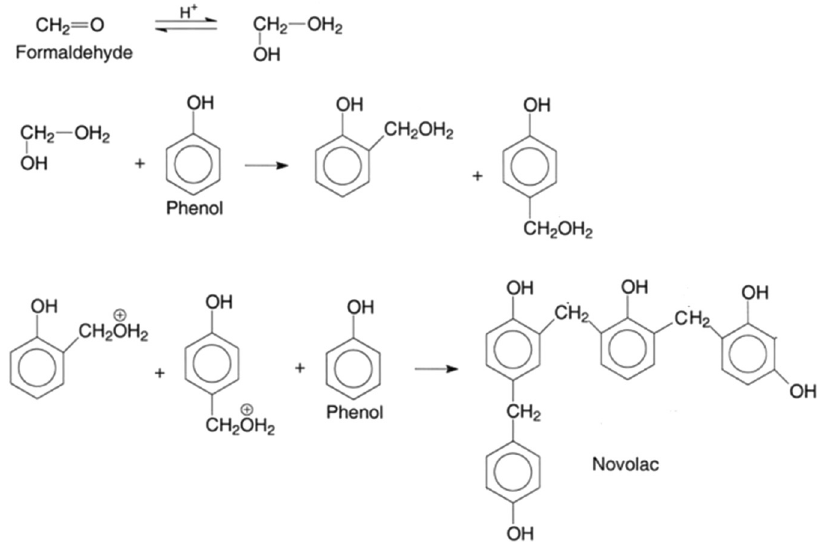
Figure 5: Synthesis reaction of novolac epoxy resins [ 28 ]